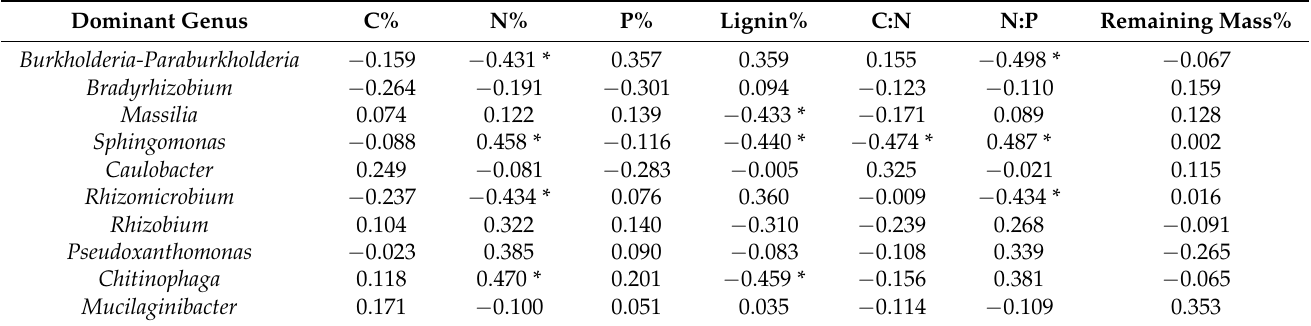
Table 6. Correlation analysis among the top 10 dominant bacterial genera, the remaining mass and the initial litter